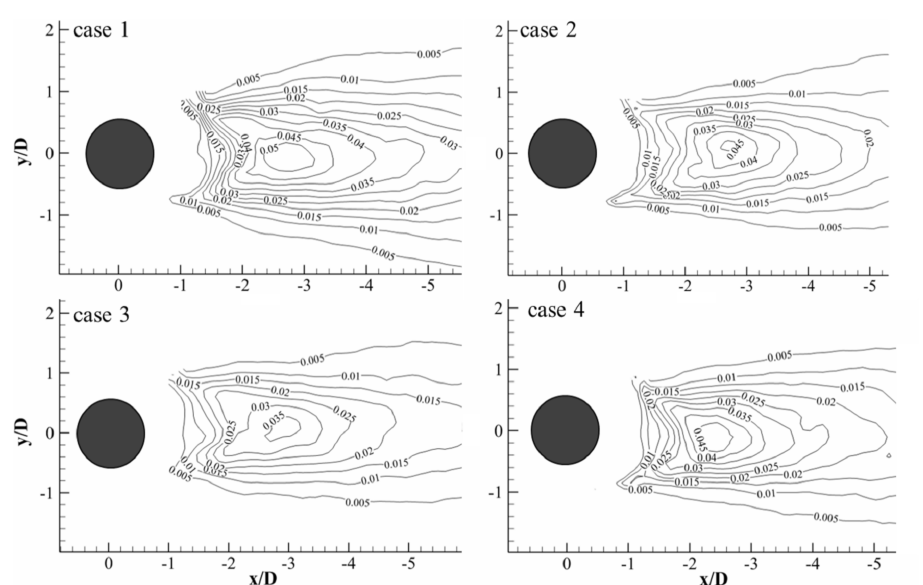
Figure 5. The distribution of turbulent kinetic energy for the smooth cylinder and the dimpled cylinder with different numbers. case 1: Smooth cylindrical; case 2: Dimpled columns is 4; case 3: Dimpled columns is 8; case 4: Dimpled columns is